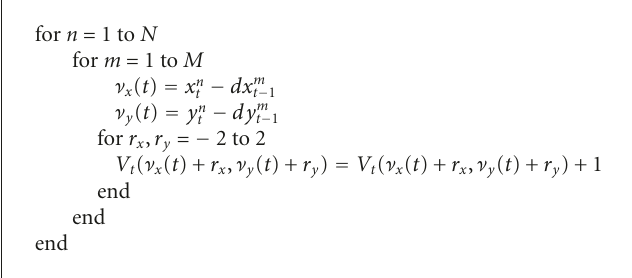
Algorithm 1: Voting procedure and